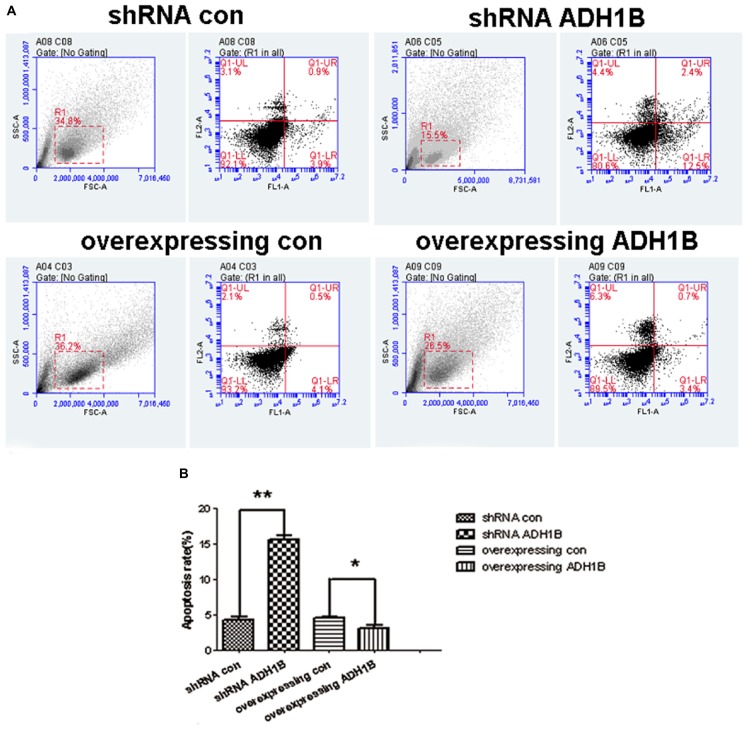
Effects of alcohol dehydrogenase 1B (ADH1B) on the apoptotic rate of SH-SY5Y cells. After treatment with 10 μM Aβ1-42, cells were divided into four groups: overexpressing ADH1B, overexpressing control, shRNA ADH1B, and shRNA control. (A) Flow cytometry (FCM) analysis of apoptosis of SH-SY5Y cells. Cell apoptosis was identified using Annexin-V/propidium iodide (PI) double-staining assays. Q2-1, Q2-2, Q2-3, and Q2-4 indicate viable (live), early apoptotic, late apoptotic, and necrotic regions, respectively. (B) Apoptotic rate of cells were determined using FCM. Data are shown as mean ± S.D. of three separate experiments performed in triplicate. Data were compared with independent samples using Chi-square tests. *p < 0.05 and ∗∗p < 0.01.